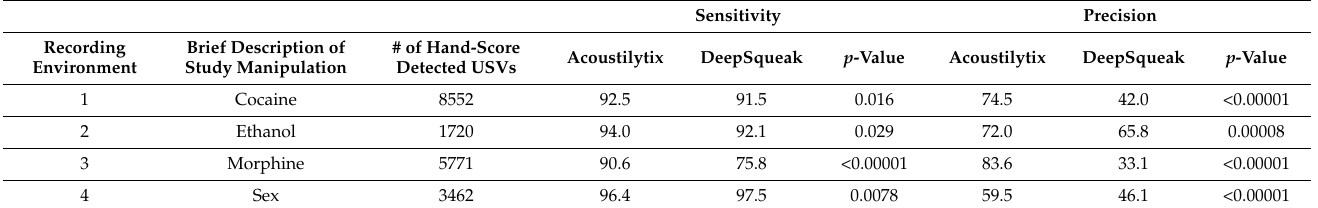
Table 1. Sensitivity and precision of Acoustilytix and DeepSqueak for four experimental conditions across four record- ing environments.